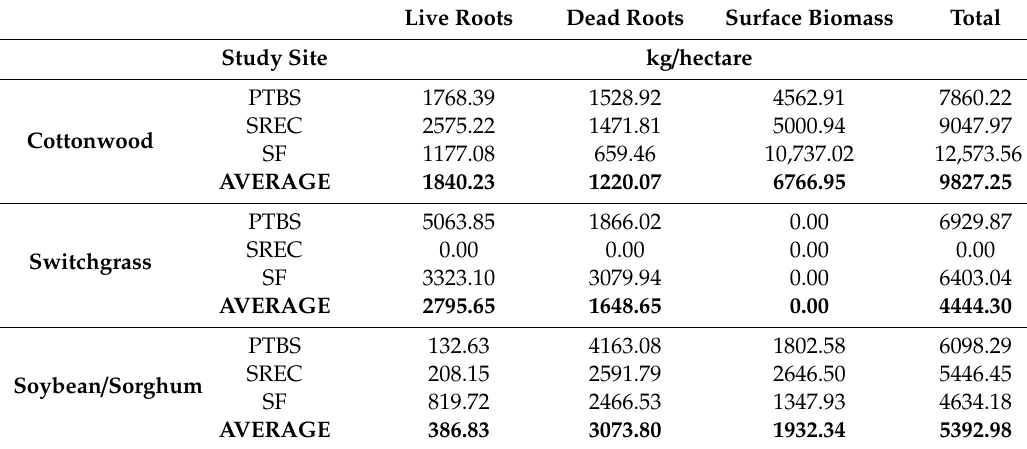
Table 3. Total biomass (dry, kg ha − 1 ) accumulated by fine roots, dead roots, and surface biomass as residue during the first three years.